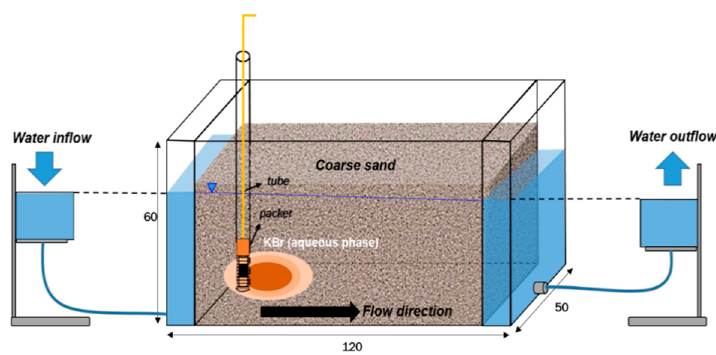
Figure 1. Schematic experimental setup for the laboratory-scale push-drift-pull tracer test.